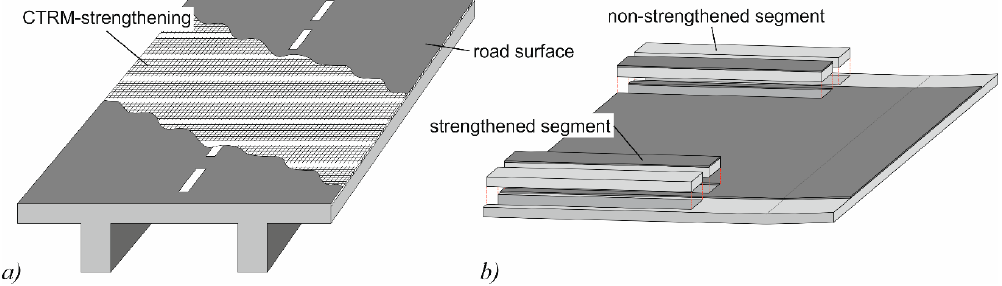
Figure 2. ( a ) Application of Smart-Deck; and ( b ) the position of sawn segments in a demonstrator